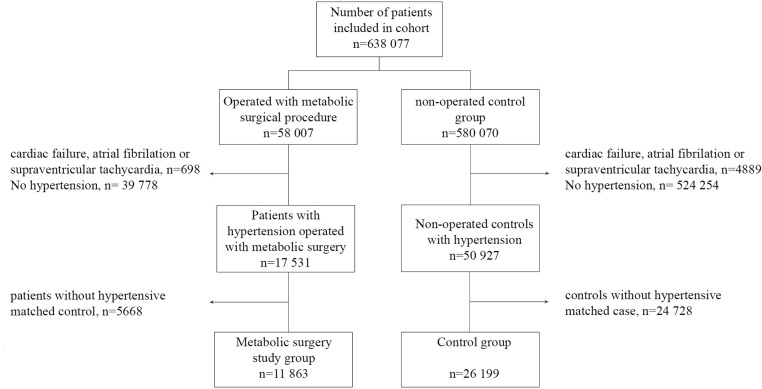
Flow chart.Flow chart describing study inclusion.